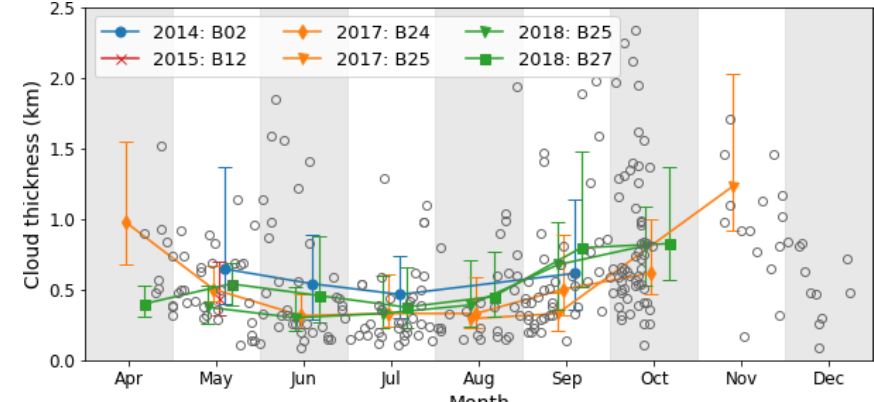
Figure 3. Monthly evolution of first layer cloud geometrical thickness (in km) for five IAOOS buoys. The markers represent the median value, and the whiskers indicate the 25th and 75th percentiles. The open circles represent individual cloud thickness values where the lidar signal sees through the cloud layer; i.e. the cloud top is clearly detected. The median and 25th and 75th percentiles are only calculated when more than 15 data points are available.